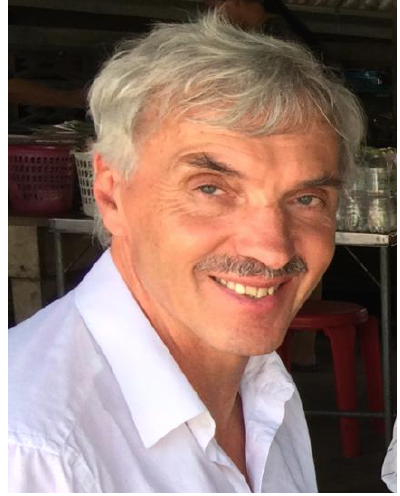
Figure A5. Ekkehard Holzbecher.